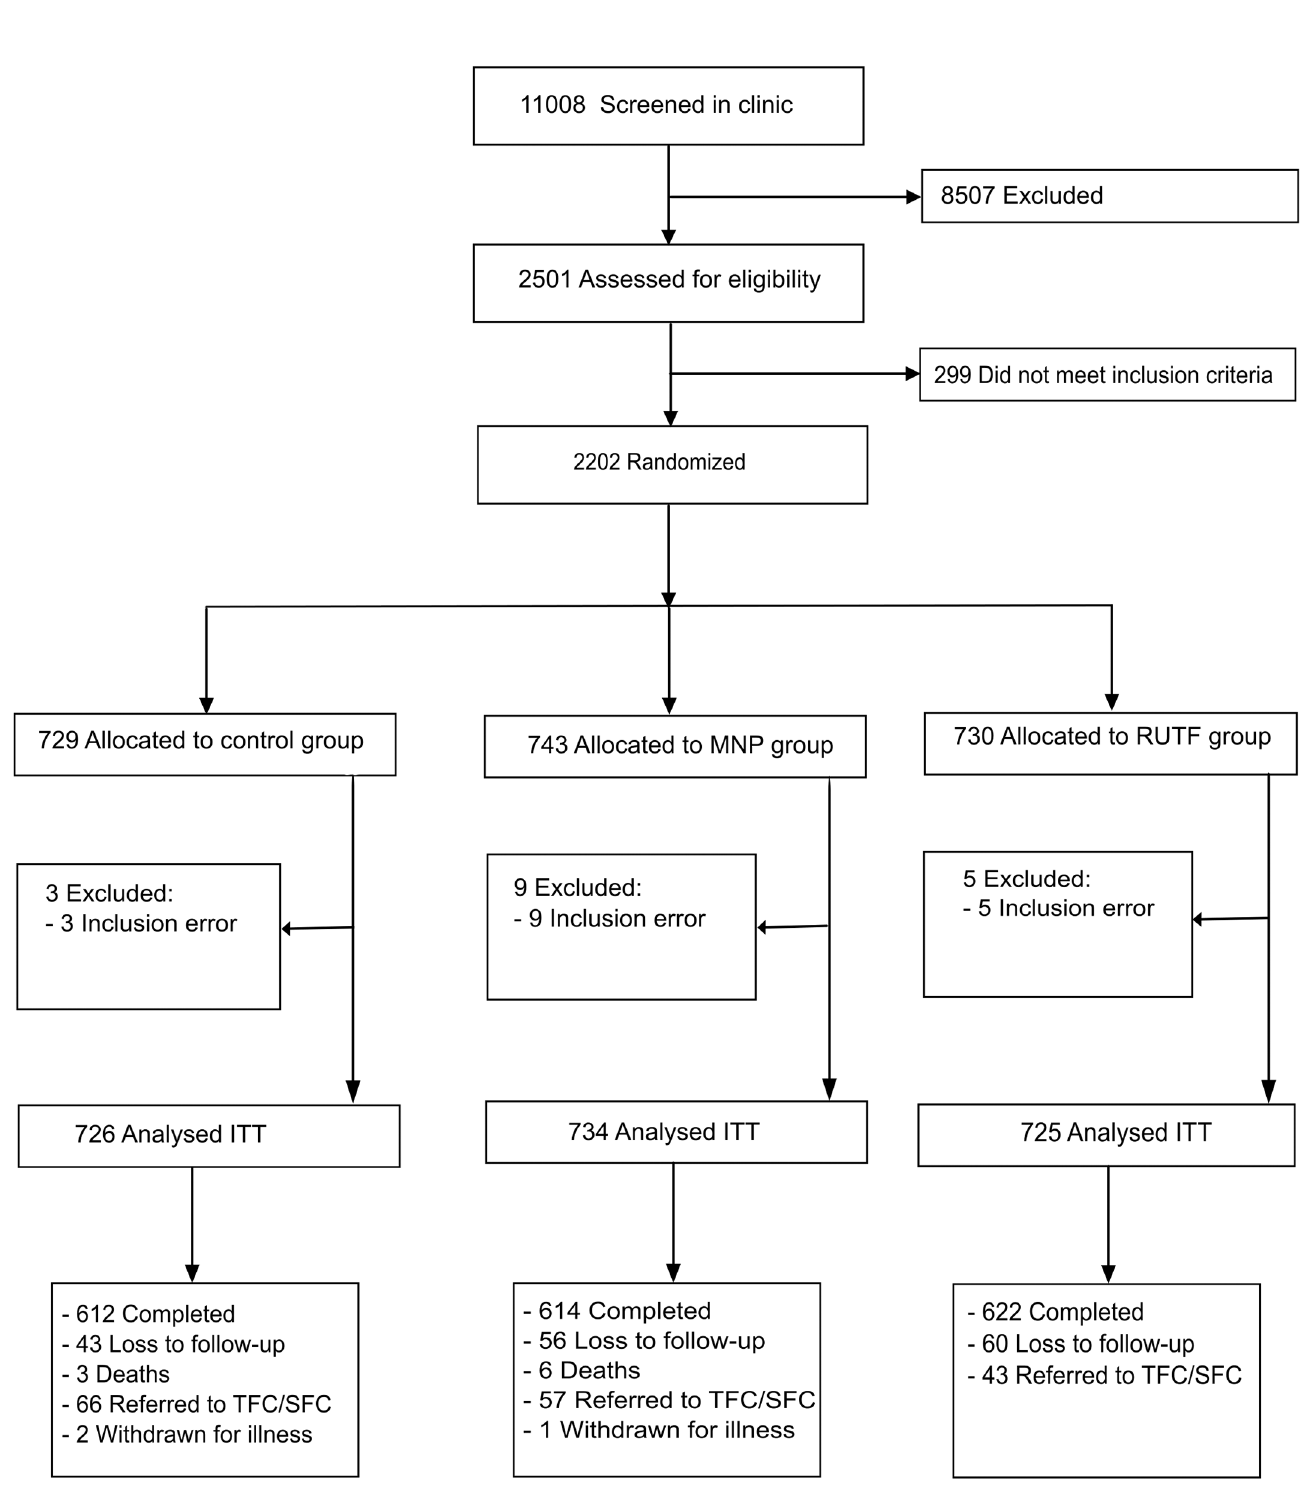
Fig 1. Flow diagram of participants ’ supplementation study in Kaabong. ITT, intention to treat; MNP, micronutrient powder; RUTF, ready-to-use therapeutic food; TFC/SFC, therapeutic/supplementary feeding centre.